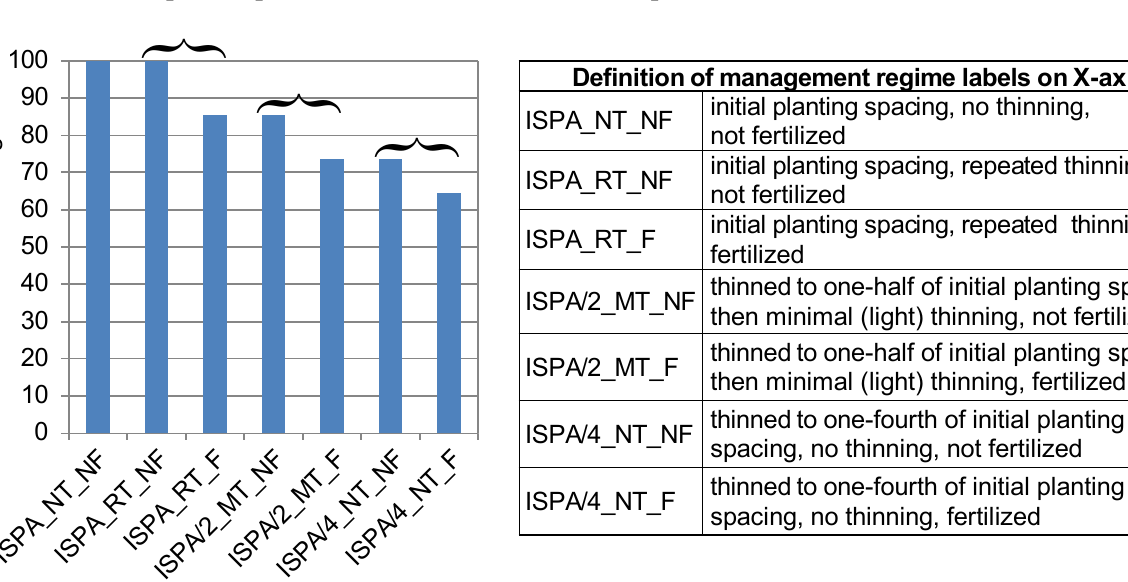
Figure 9. Conformance of seven silvicultural regime plots on the Twin Peaks field trial to a 35 mm upper specification on DLLBH, the diameter of the largest breast height branch; bracketed pairs represent unfertilized vs. fertilized plots